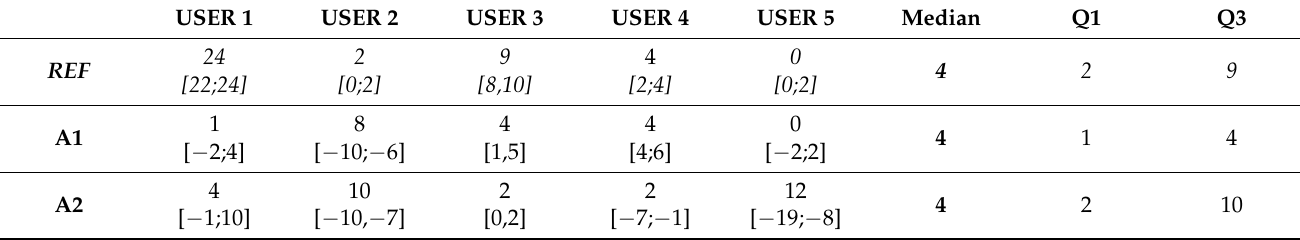
Table A3. Difference between the user cadence and the target